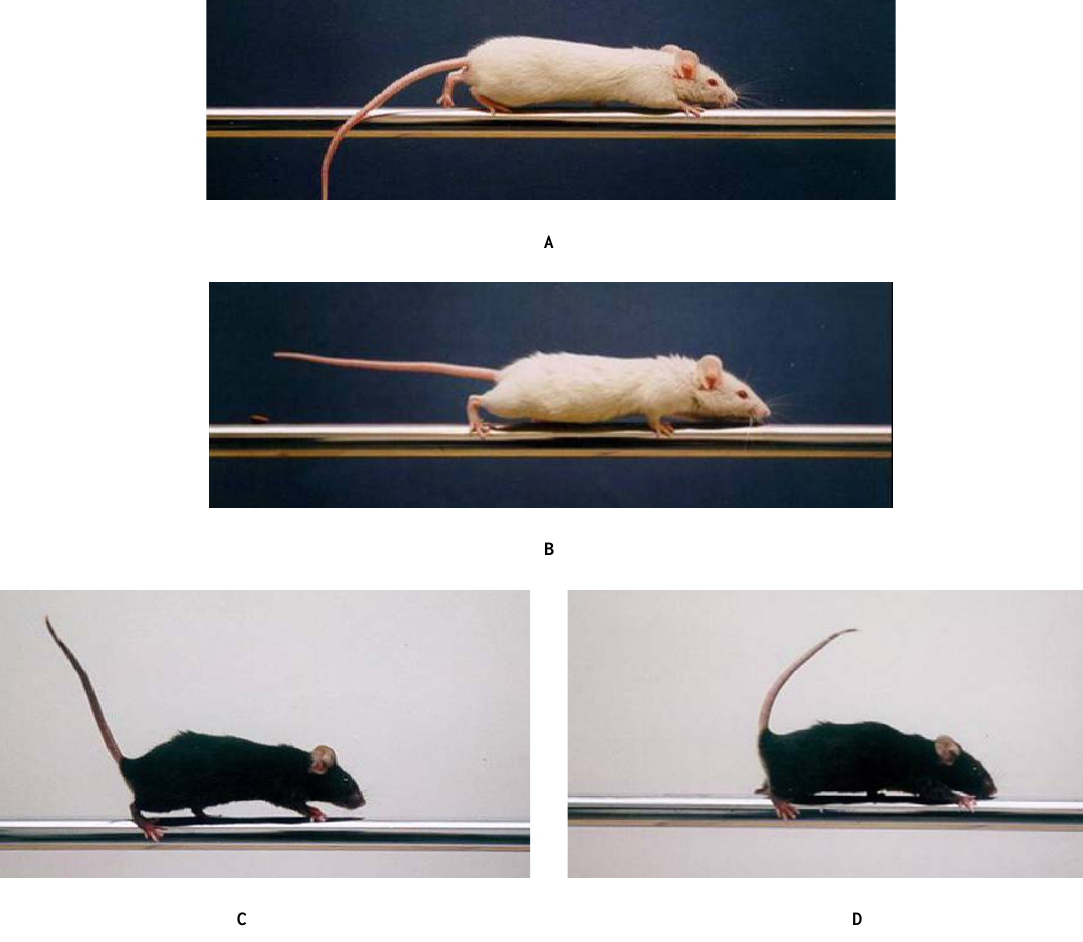
FIGURE 5. Effects of diazepam and beta-CCM on rotating beam performance . (A) Anxious BALB/c mice recorded a higher number of imbalances (at least one paw losing contact with the bar) and more falls; the trunk was low and the angle of the tail was narrow. (B) All these parameters were reversed by the administration of the anxiolytic, diazepam (0.5 mg/kg, i.p . ). (C) Nonanxious C57Bl/6J mice walked along the rotating rod without any imbalances or falls, using their tails to balance, keeping their trunks well above the rod, and keeping their tails rigid and at a high angle from the horizontal. (D) This was substantially reversed by the administration of an anxiogenic, beta-CCM (1.5 mg/kg, i.p . ); the mice lost their balance, fell, kept low, and lost the rigidity of their tails, thereby losing the ability to use the tail to balance the body; they did not, however, reduce the tail angle significantly. (Adapted from Lepicard et